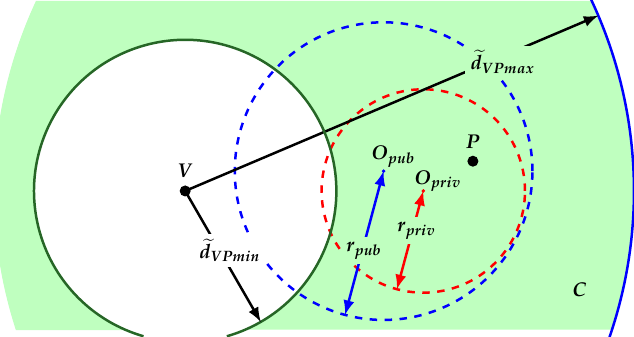
Figure 2. Attack of refinement that determines the region C , color region, in which P and the region R Fpub , color region within the major circumference, must be